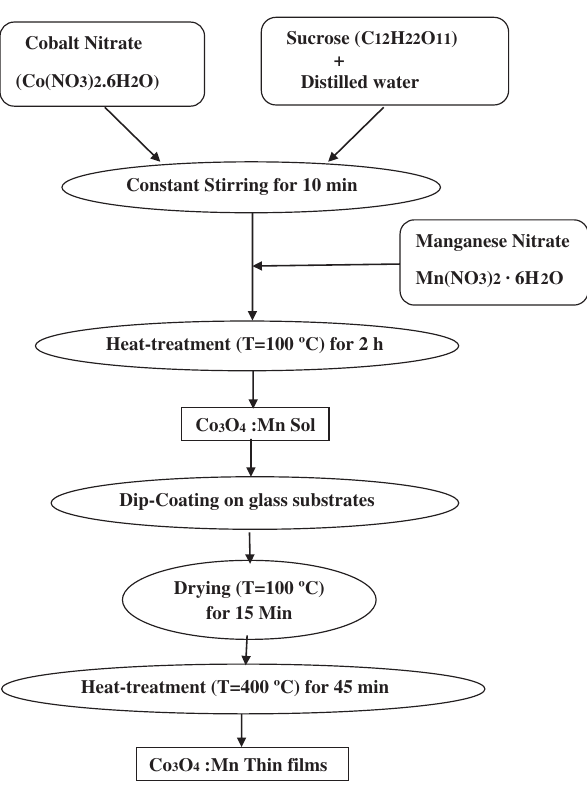
Figure 1: Schematic diagram of sol gel process of Mn-doped Co 3 O 4